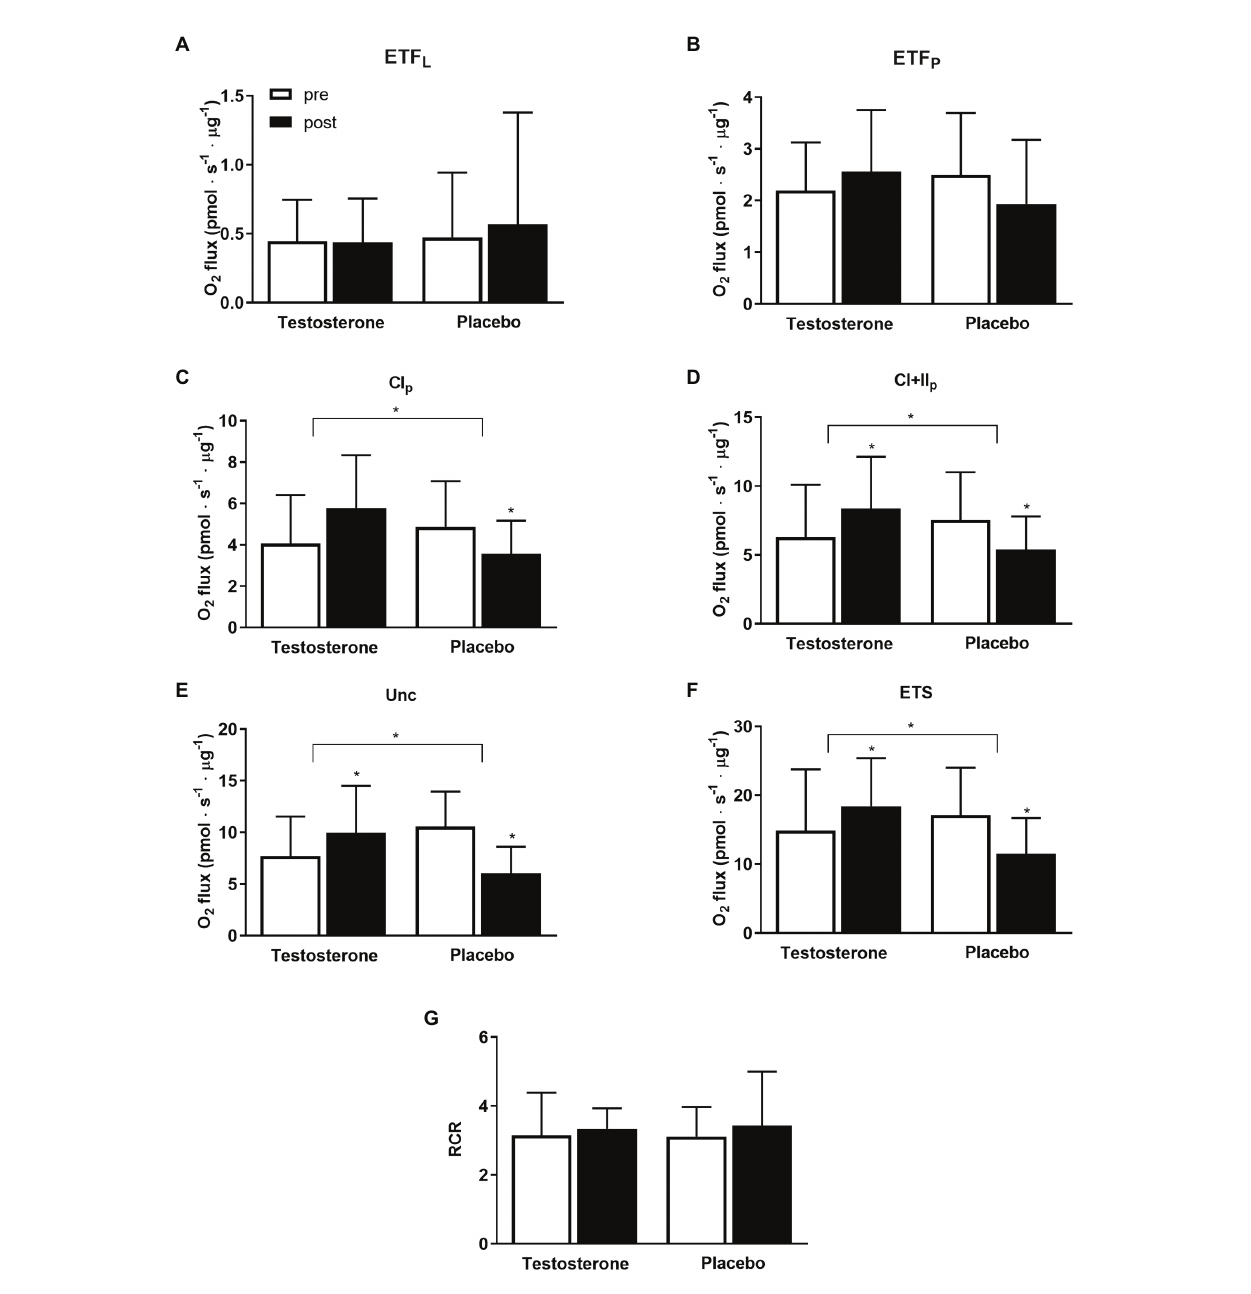
FIGURE 4 | Specific mitochondrial respiratory flux from the measurement of isolated mitochondria preparation pre (white bars) and post 10 weeks (black bars) of either 10 mg of testosterone cream daily or placebo. O 2 flux is presented as means ± SD in pmols −1 μ g −1 protein. Leak respiration ( A – ETF L ; p = 0.62, testosterone n = 17, placebo n = 15); mitochondrial respiratory flux activating electron-transferring flavoprotein complex ( B – ETF P ; p = 0.12, testosterone n = 17, placebo n = 15); complex I ( C – CI; p = 0.005, testosterone n = 17, placebo n = 15); linked complex I and II ( D – CI + II; p = 0.004, testosterone n = 19, placebo n = 15); uncoupling state ( E – Unc; p = 0.004; testosterone n = 14, placebo n = 10); electron transport system capacity ( F – ETS; p = 0.001, testosterone n = 18, placebo n = 10), and respiratory control ratio (G) are reported. * = p < 0.05. Between-group differences in the changes from pre to post treatment with the baseline measurement as a covariate are indicated with the bracket and the * symbol. The * symbol over the bar indicates a within-group difference in the pre to post